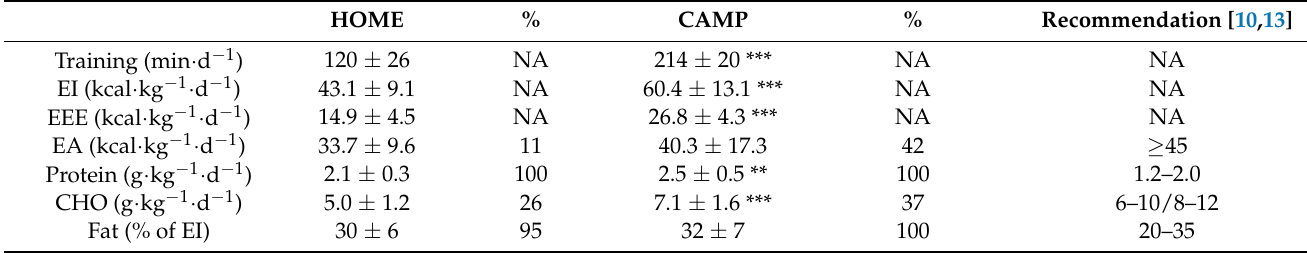
Table 1. Mean ( ± SD) daily training volume, energy and macronutrient intake, exercise energy expenditure, and energy availability in young female cross-country skiers (n =